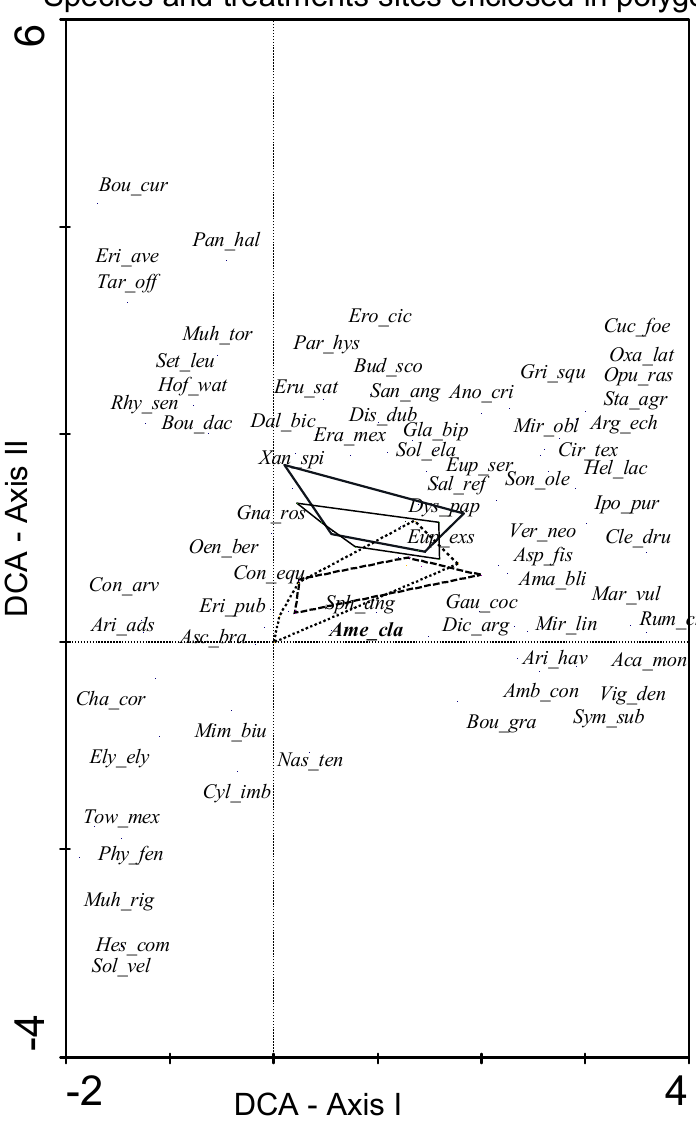
Figure 5. Detrended correspondence analysis axes I and II. Species coordinates and treatment plots’ coordinates (each treatment with a different symbol). Eigenvalues for axis I: 0.30, eigenvalue for axis II: 0.14, cumulative percentage of total inertia for axes I and II: 26.4%. Polygons enclosed plots under same treatment: Polygon with a slashed line for control plots, dotted line for clipped plots, solid thick line for burned plots, and solid thin line for herbicide plots (species names use the three first letters of the genus, followed by the three first letters of the specific epithet from Appendix A).